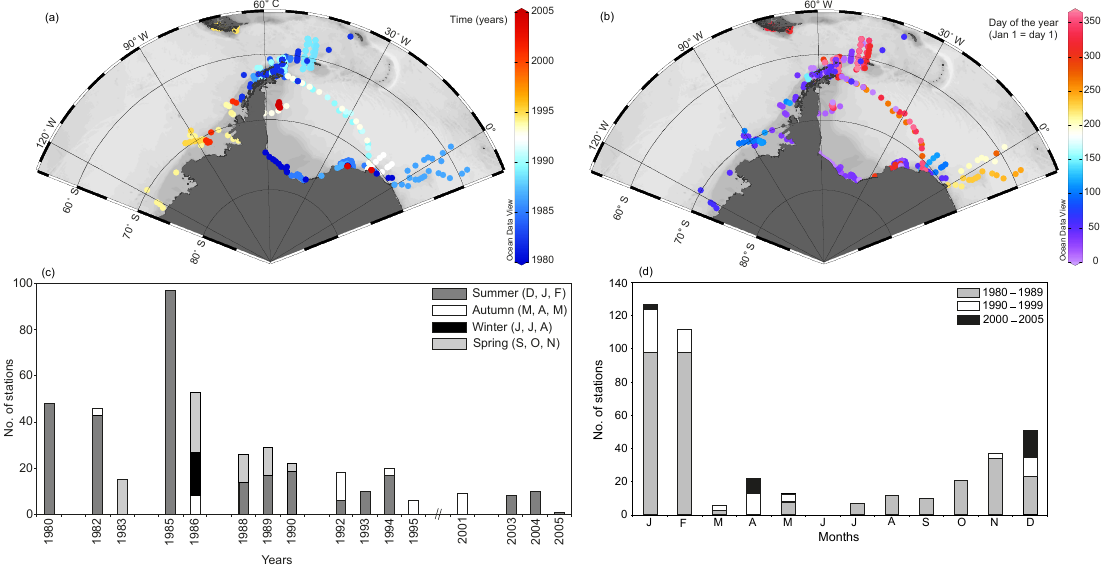
Figure 2. Sampling effort in the Southern Ocean: (a) station distribution in years, (b) station distribution in the annual cycle, (c) number of stations per year and season, (d) number of stations per month and